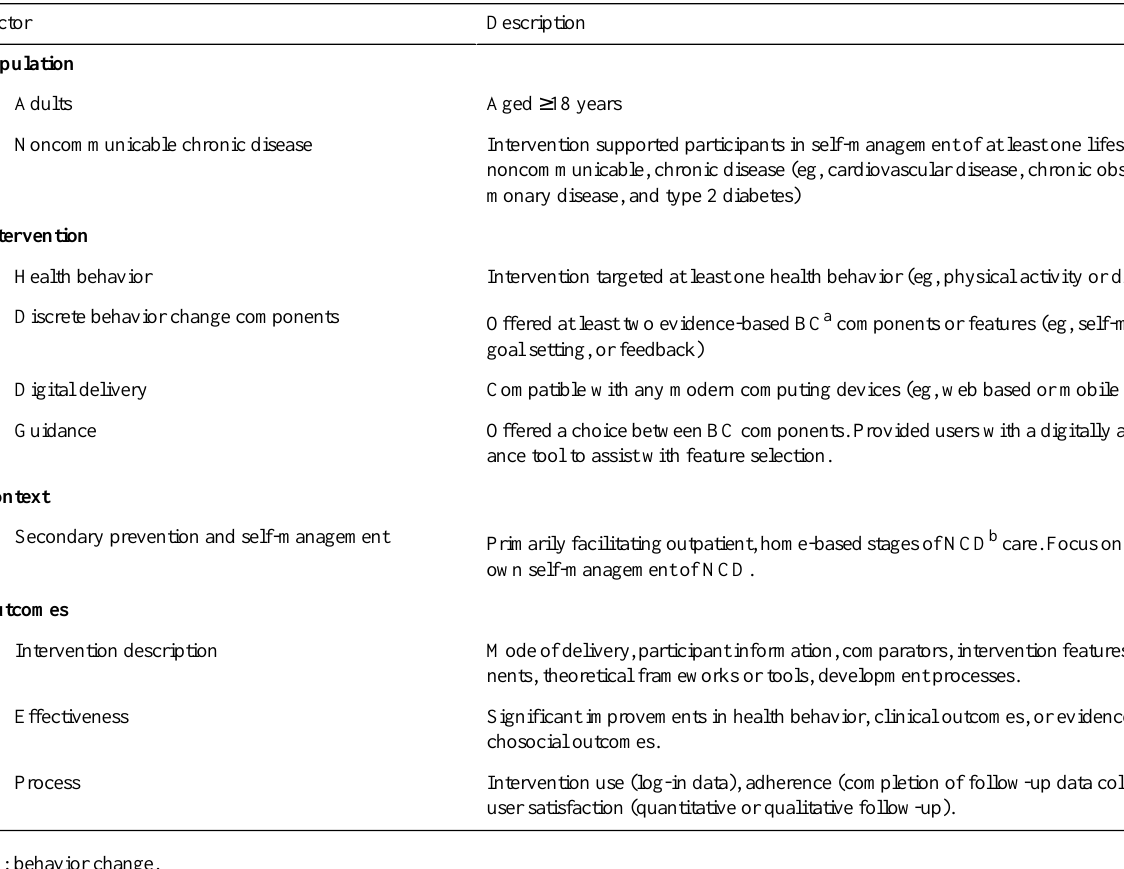
Table 1. Framing the review aims according to an adapted Population, Intervention, Context, Outcome